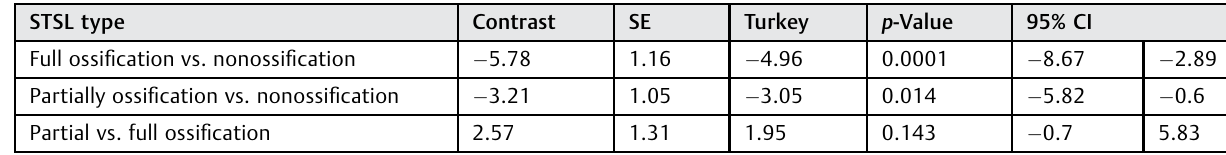
Table 2 Results of pairwise comparison of notch transverse diameters regarding STSL ossi fi cation status STSL